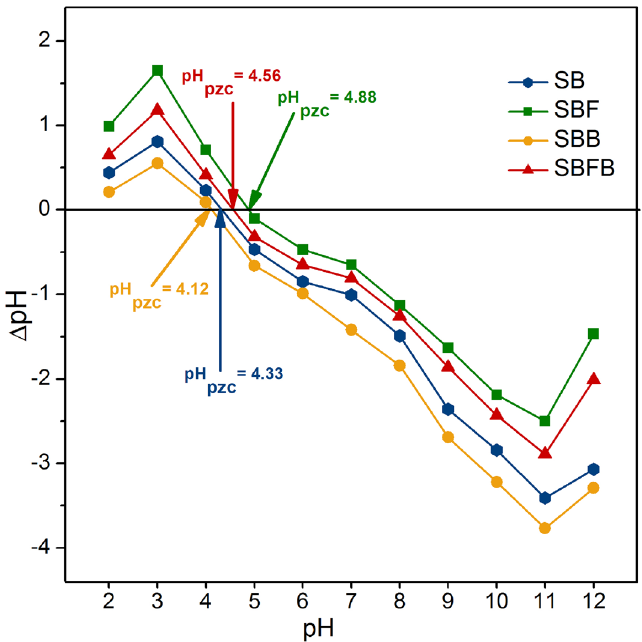
Figure 5. The point of zero charges of sugarcane bagasse powder (SB), sugarcane bagasse powder doped iron(III) oxide-hydroxide (SBF), sugarcane bagasse powder beads (SBB), and sugarcane bagasse powder doped iron(III) oxide-hydroxide beads (SBFB) for lead